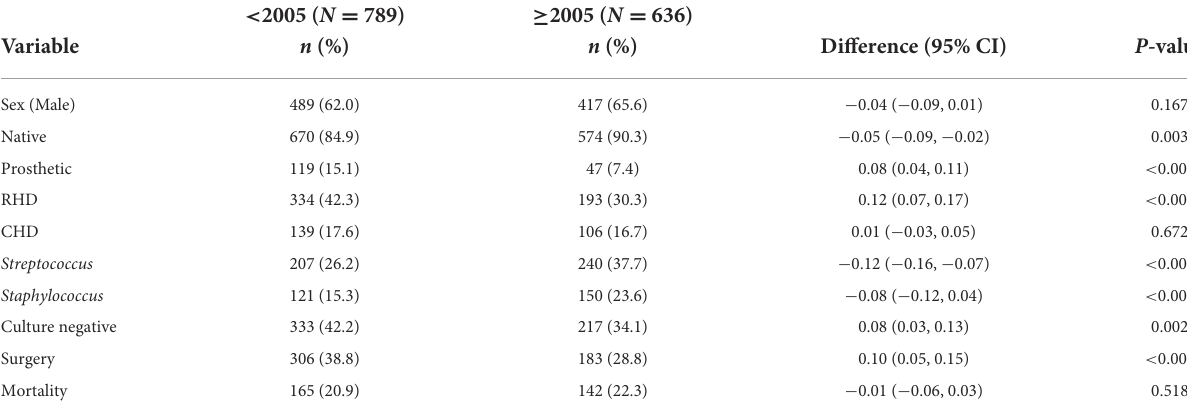
TABLE 3 Comparison of the two IE cohorts in respect to several